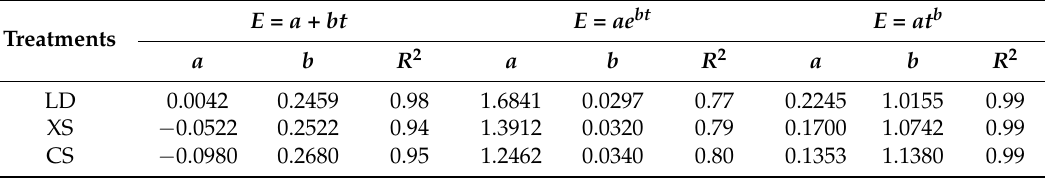
Table 2. Fitting equation for evaporation amount under different sand mulches.